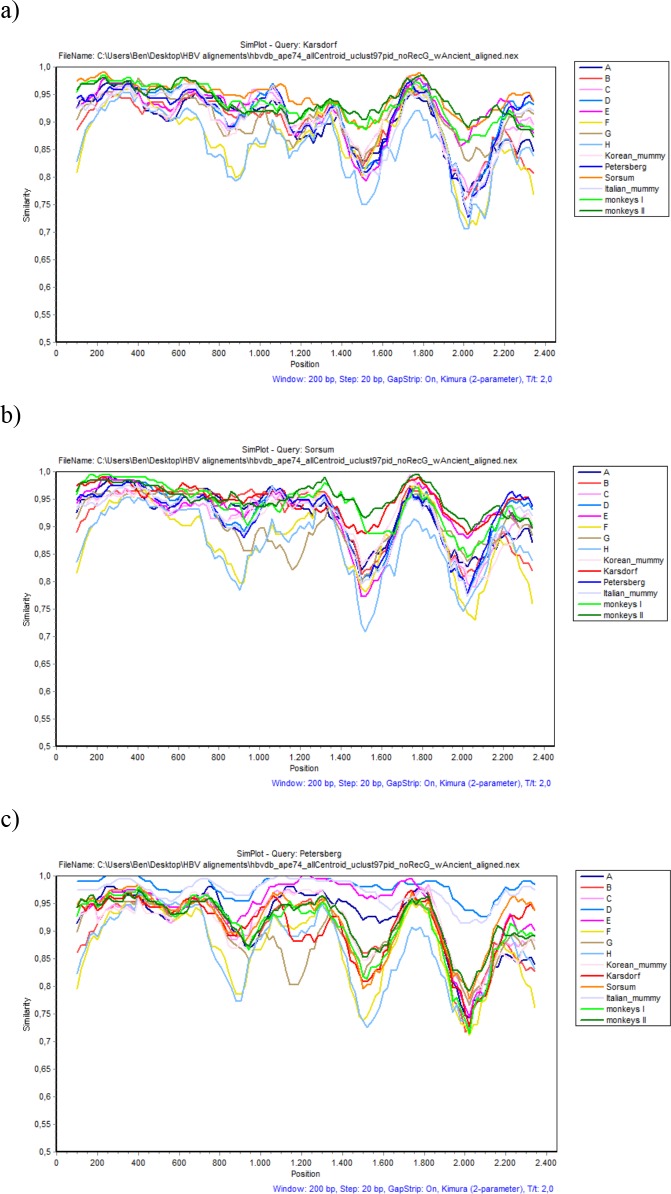
SimPlot analysis of (a) Karsdorf, (b) Sorsum and (c) Petersberg.In each case, sequence fragments of 200 bases incrementing by 20 bases, 100 bootstrap replicates, were compared with sequence groups of the eight human genotypes, four primate genotypes and four ancient genomes (color coded as described in the legend).